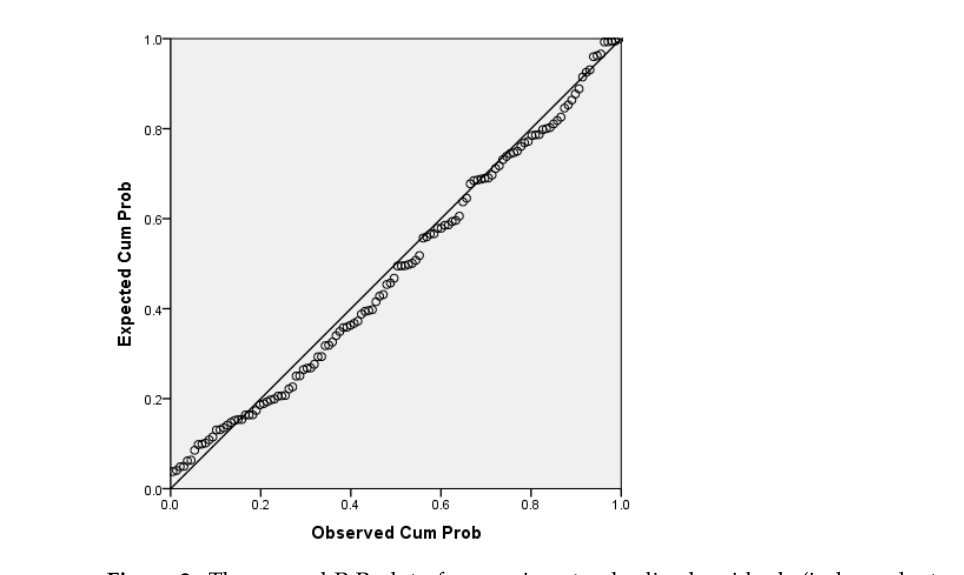
Figure 2. The normal P-P plot of regression standardized residuals (independent variables BMI, dependent variable FQRST.